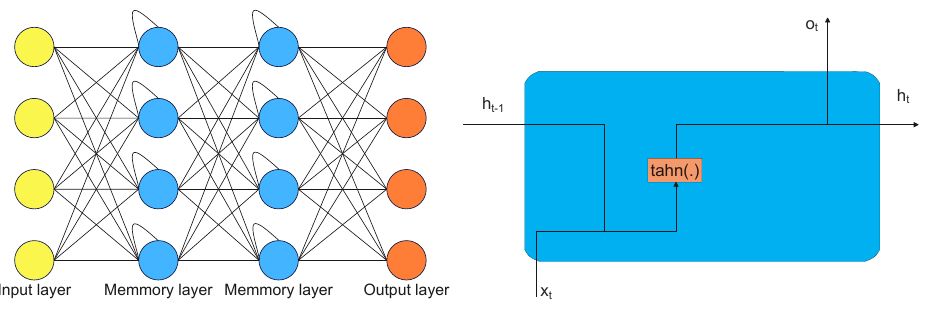
Figure 5. Typical RNN